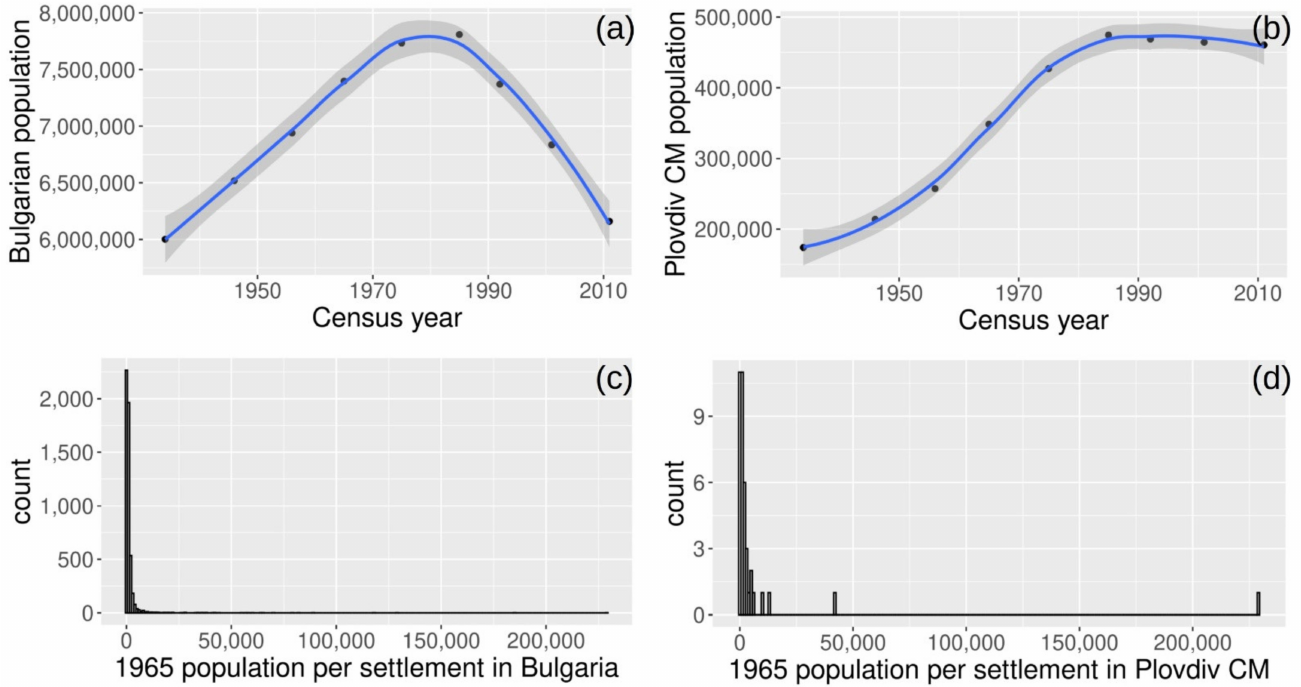
Figure 4. Temporal change in total population for Bulgaria ( a ) and per settlement within the Plovdiv City Municipality (CM) ( b ) based on Census decadal data and distribution of settlements (bin of 1000) for Bulgaria ( c ) and the study area ( d ) in the year